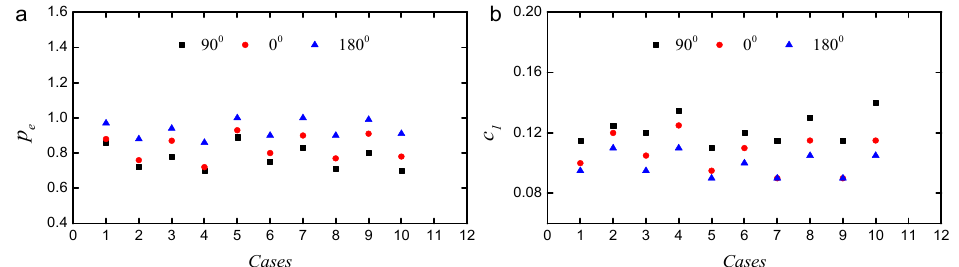
Figure 11. Comparison of ( a ) p e and ( b ) c 1 for the vertical jet and horizontal jets in the same wave environments.